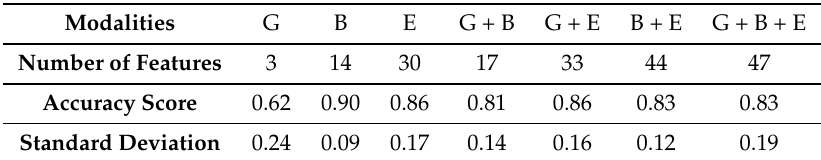
Table 4. Best accuracy scores from cross-validation for SVMs (10-Fold Cross Validation). The number